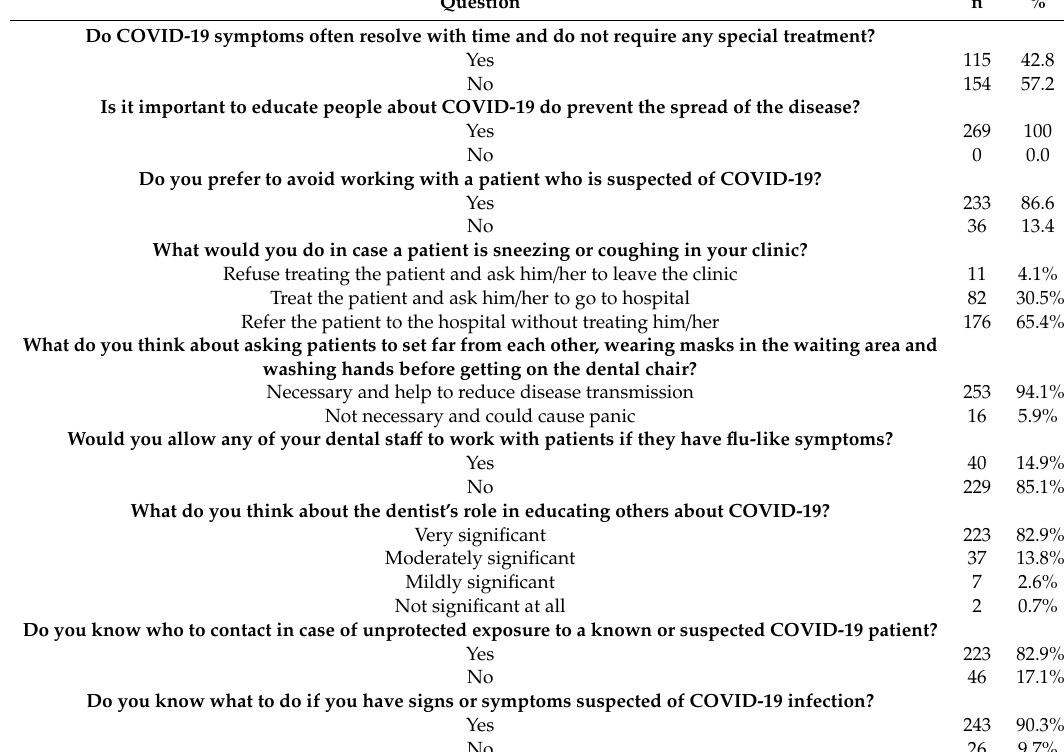
Table 3. Participants’ responses to attitude and preparedness